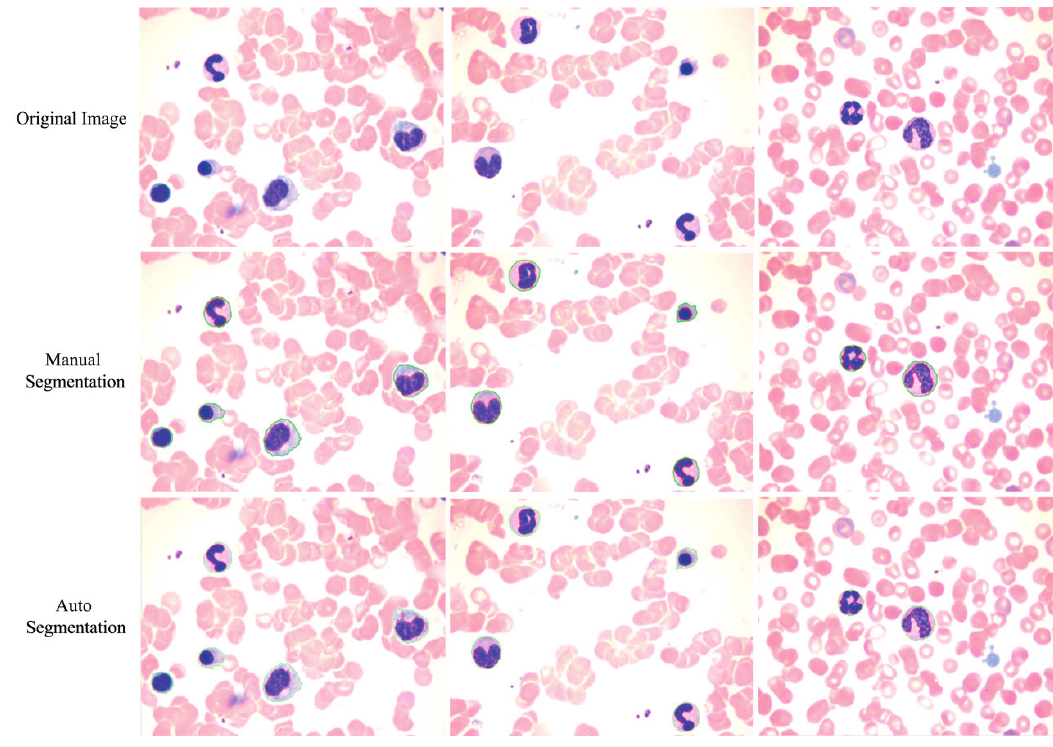
Figure 15. Comparison of the proposed method and the manual method on multiple WBC segmentation.